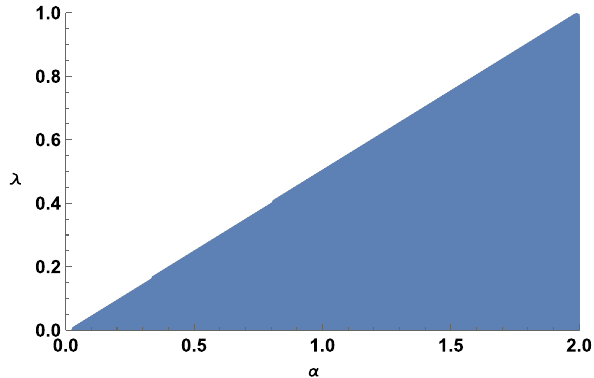
Fig. 9 The figure describes a specific region where the de-Sitter crit- ical point B is stable. The figure takes into account also the existence conditions, implying that the y component is real and